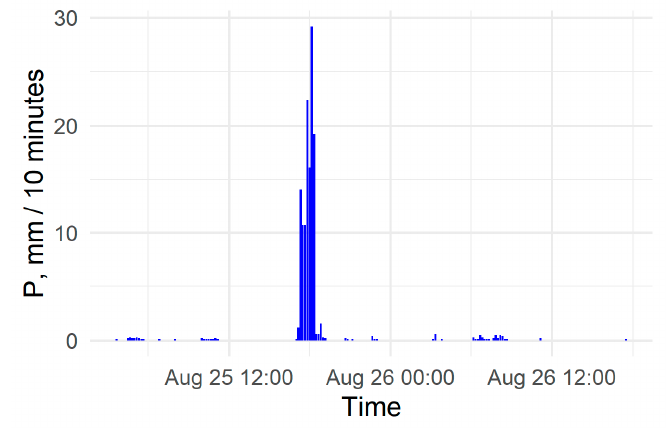
Figure A2. An extreme event: More than 20% of the annual precipitation occurred during 70 min.